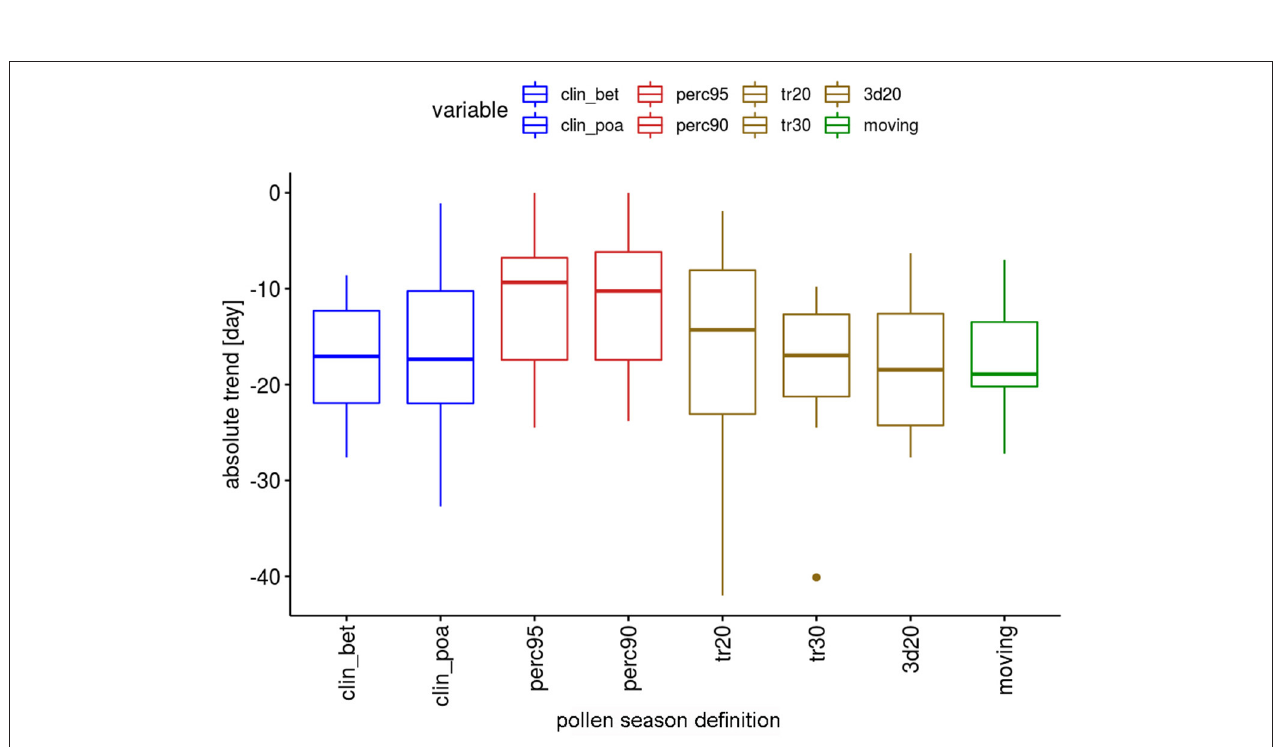
FIGURE 2 | Range of absolute trends [days] for the 50-year period 1969–2018 of the start dates of the pollen season by definition for 12 pollen taxa.